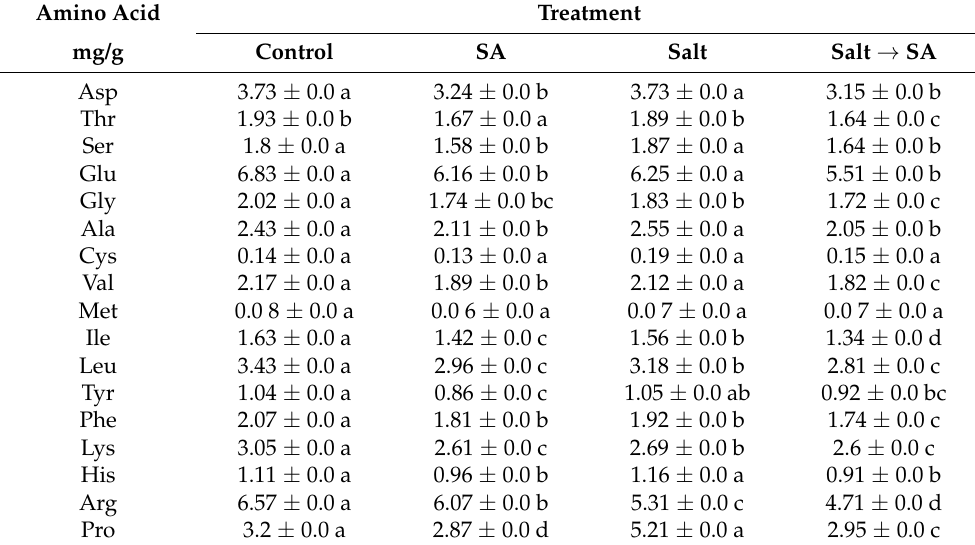
Table 2. Effect of salicylic acid on endo-amino acid content in salinity-stressed St. John’s wort seedlings. Amino Acid